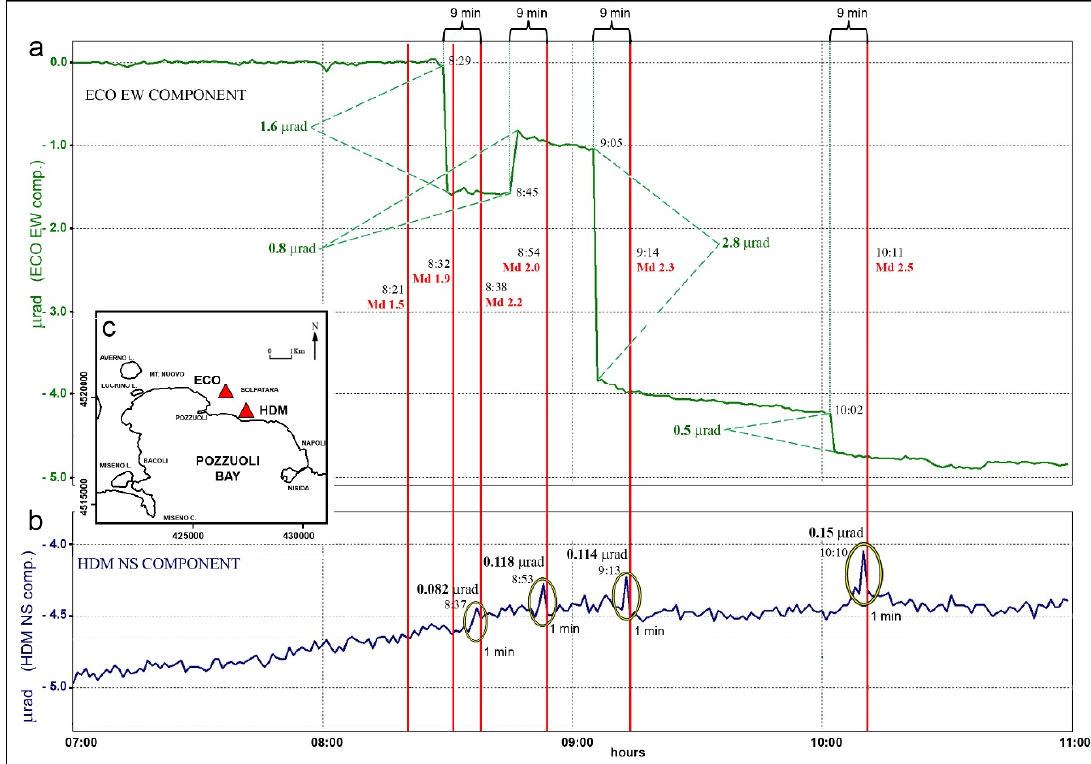
Figure 5. Detailed analysis of the 4-hour long time series recorded before and after the earthquakes of October 7, 2015 observed at ( a ) ECO (EW component in green) and ( b ) HDM (NS component in blue). The EW component recorded four distinct offsets ranging between 0.5 and 2.8 μ radians 9 minutes before the four most energetic VTs (red vertical lines); instead the NS component of HDM always showed peaks on the signal 1 minute before the VT. ( c ) Location of the ECO and HDM tilt stations.